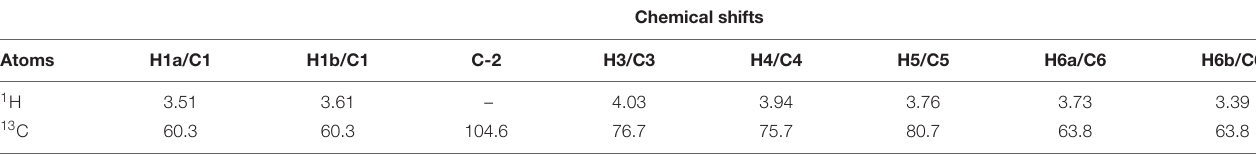
TABLE 2 | HSQC chemical shifts data ( δ or ppm) in D 2 O of the fructosyl residue of levan-type fructan polysaccharides from G. marginata underground storage system.